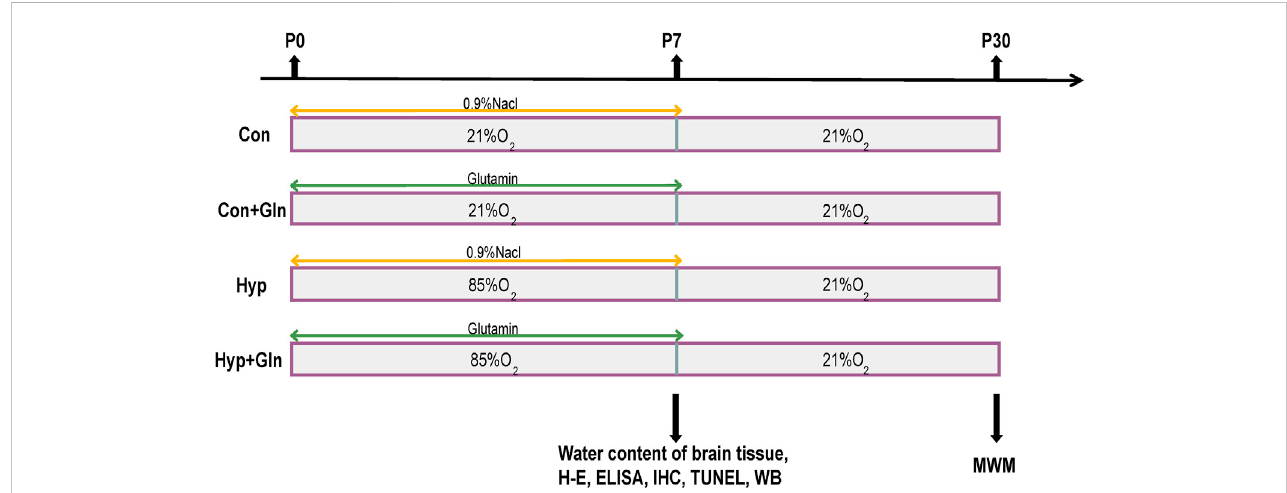
FIGURE 1 Theexperimentalprocedure.Newbornratswererandomlydividedintofourgroups:Con,Con+Gln,HypandHyp+Gln.TheHypandHyp+Glngroups were placed in 85% O 2 for 7 days, Con and Con + Gln groups were placed indoor (21% O 2 ). Gln [1 μ g/g (B)W] was administered intraperitoneally to newborn ratsintheCon+ Glnand Hyp+ Glngroups atthesame time eachday,and thesamevolume of0.9%NaClwasadministered intraperitoneallytonewbornrats in the Con and Hyp groups at the same time for 7 days. At P7, each group of randomly selected newborn rats for histopathological analysis ( n = 3), determine the water content of brain tissue ( n = 3) and protein analysis ( n = 3). At P30, each group of neonatal rats ( n = 6) began the Morris water maze experiment. Con, control; Hyp, hyperoxia; Gln, glutamine; P0, postnatal day 0; P7, postnatal day 7; P30, postnatal day 30; IHC, immunohistochemistry; WB, western blot; MWM, morris water maze